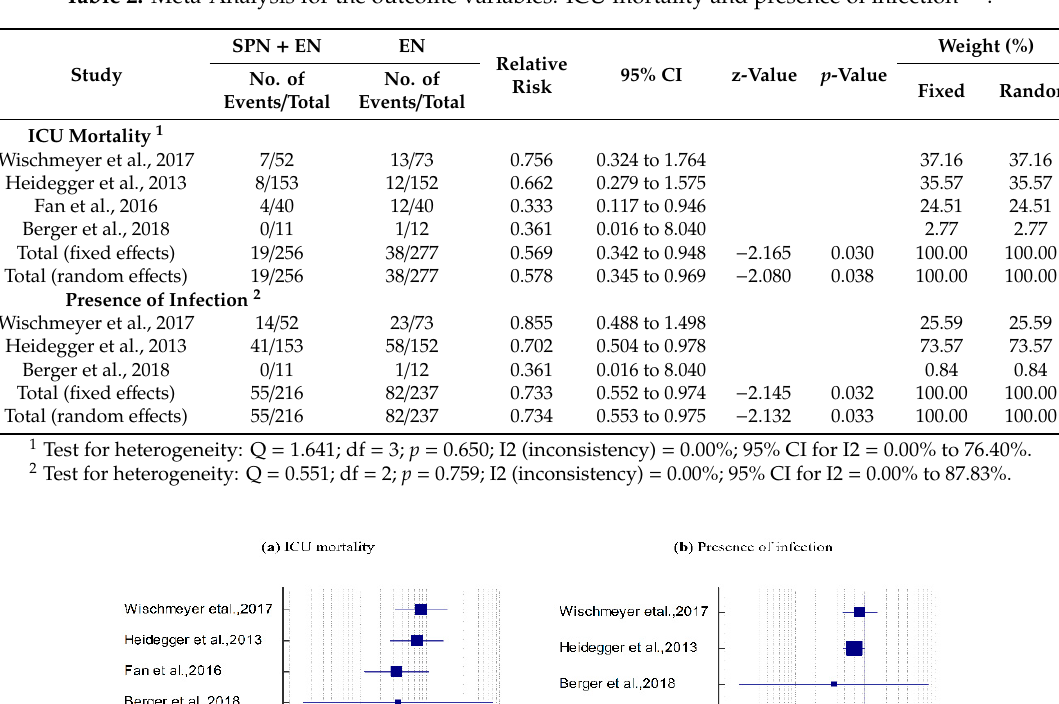
Table 2. Meta-Analysis for the outcome variables: ICU mortality and presence of infection 1,2 .